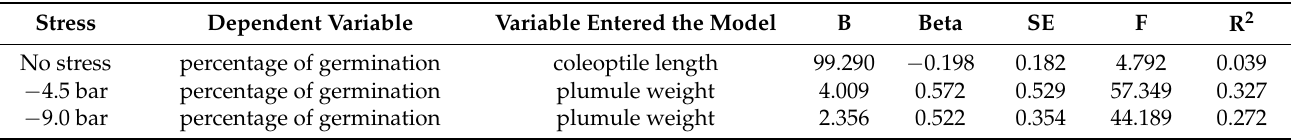
Table 2. Results of stepwise regression for germination percentage as a dependent variable and other traits as independent variables in